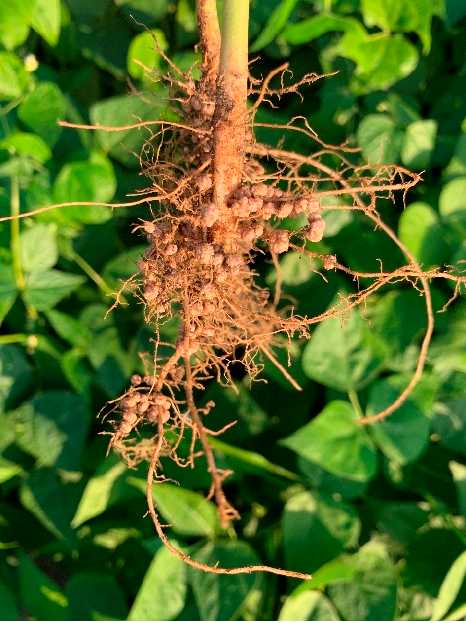
Figure 1. Nodulated root of Phaseolus vulgaris . Credits: Ederson da Conceição Jesus.